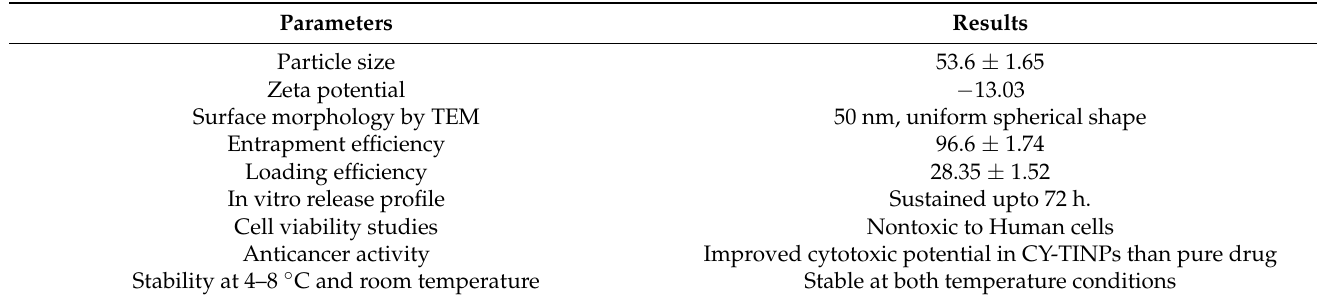
Table 1. Characterization and results of optimized cytarabine-loaded TINPs (CY-TINPs) (n = 5, mean ± SD).